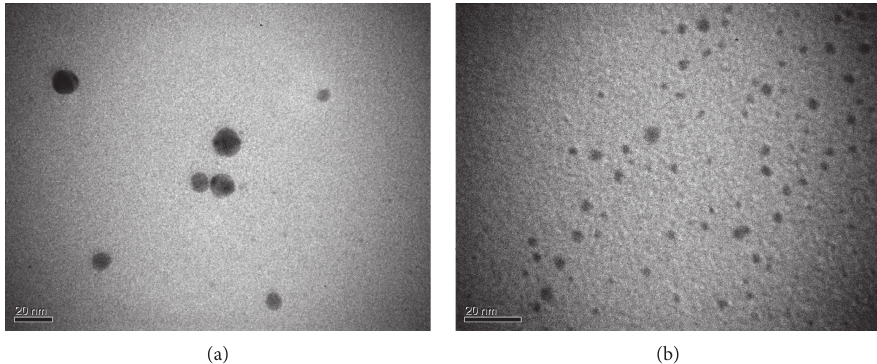
Figure 3: TEM images of AgNPs synthesized in solution NaPA (5g L-1) by cyclic voltammetric (during 20 cycles) without ultrasonic field (a) and in the ultrasonic field (b), t � 20 ° C. Reproduced from [41] under the terms of the Creative Commons CC BY license.